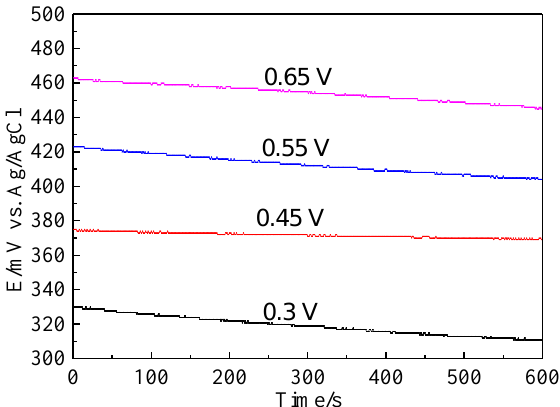
Figure 10. The open circuit potential of bornite electrode after treating by different potentials for 3 h in 9K bacterial culture medium (Conventional three-electrode system on a Princeton Model 283 Potentiostat, EG&G of Princeton Applied Research).